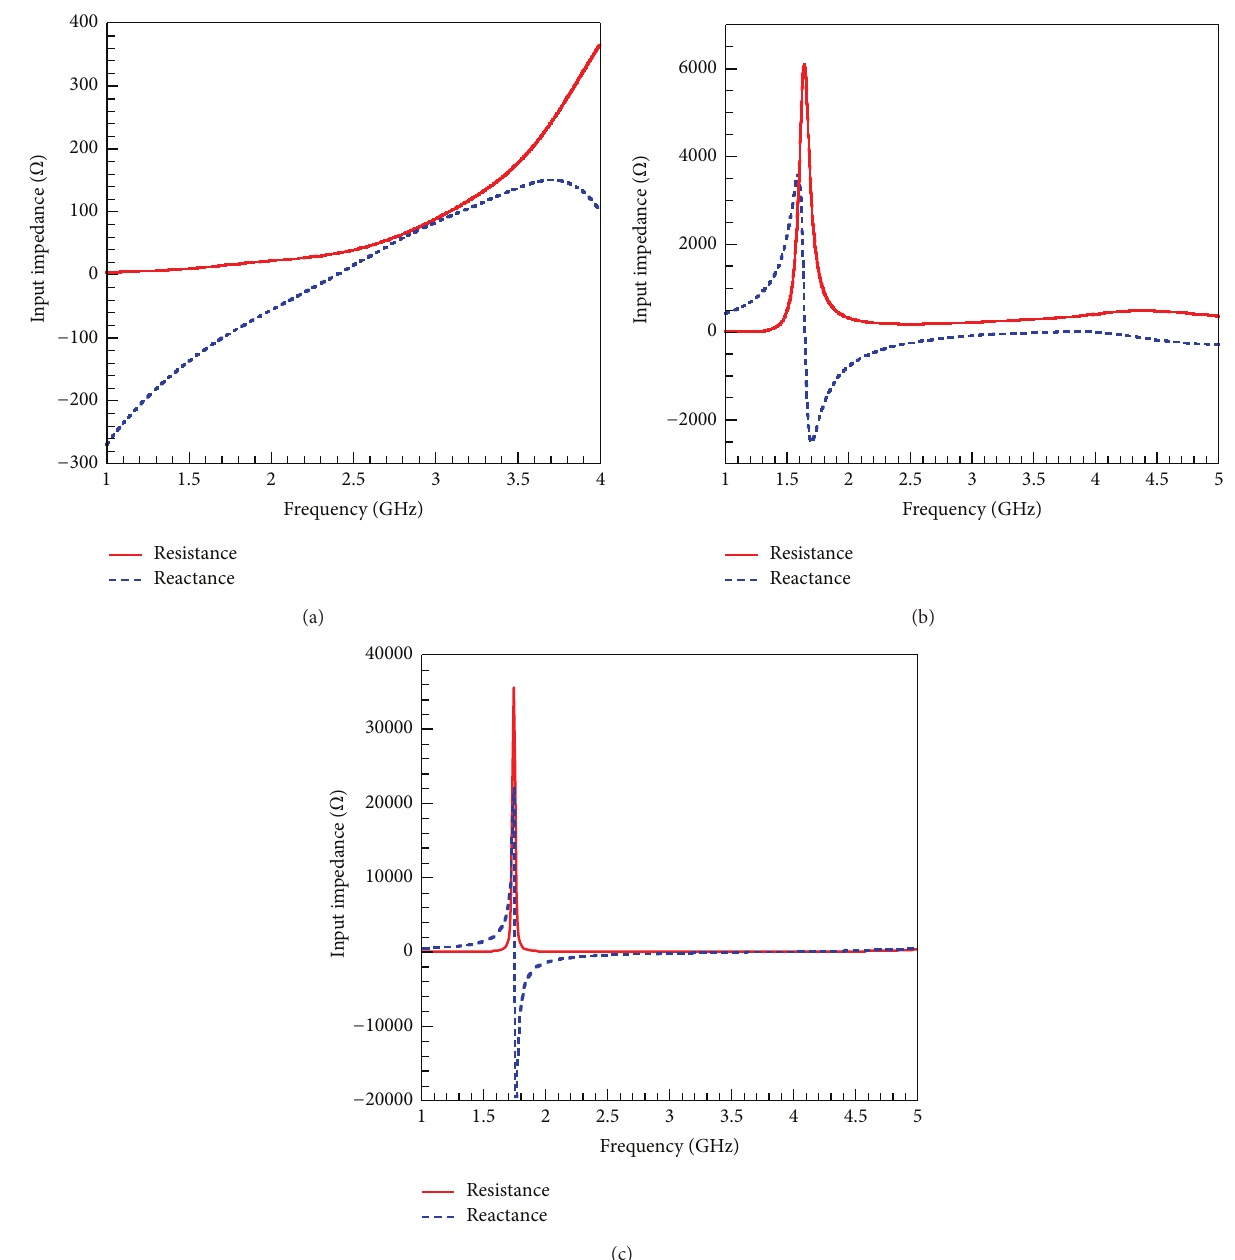
Figure 4: Simulated complex input impedance of the (a) monopole alone; (b) SRR alone (configuration A1); (c) SRR alone (configuration